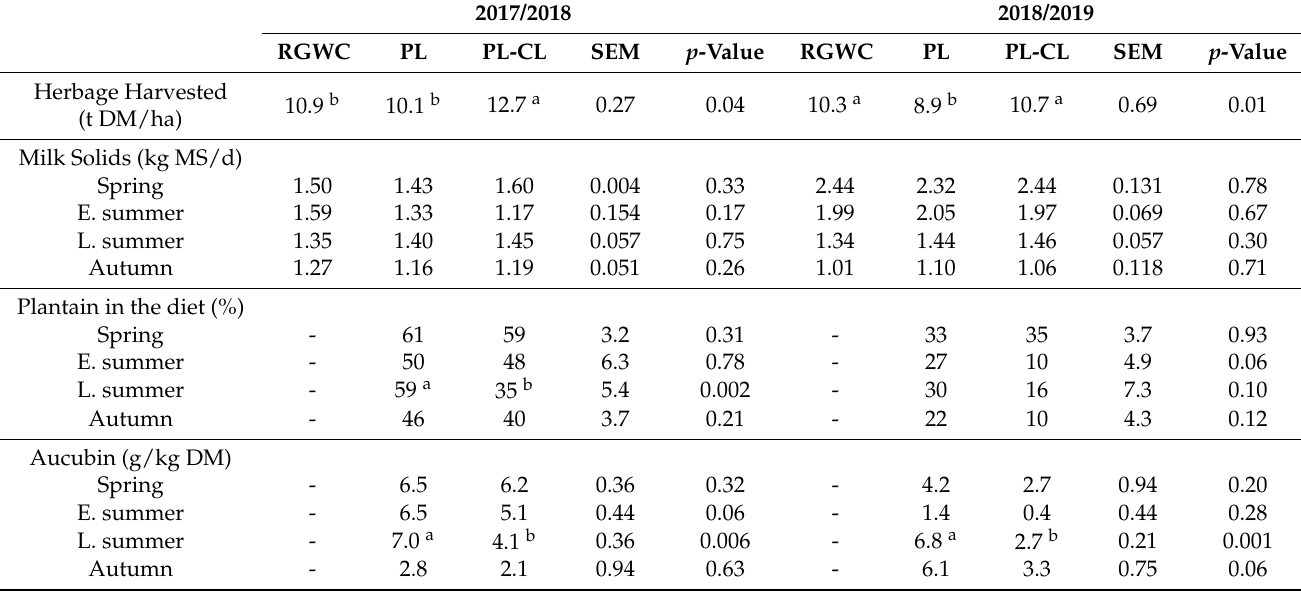
Table 2. Total herbage harvested by lactating cows during the 2017/2018 and 2018/2019 lactation seasons and milk solids (MS) production, proportion of plantain in the total diet, and aucubin concentration in plantain (PL), plantain–clover (PL-CL), and ryegrass-white clover (RGWC) pastures in spring, summer (early and late), and